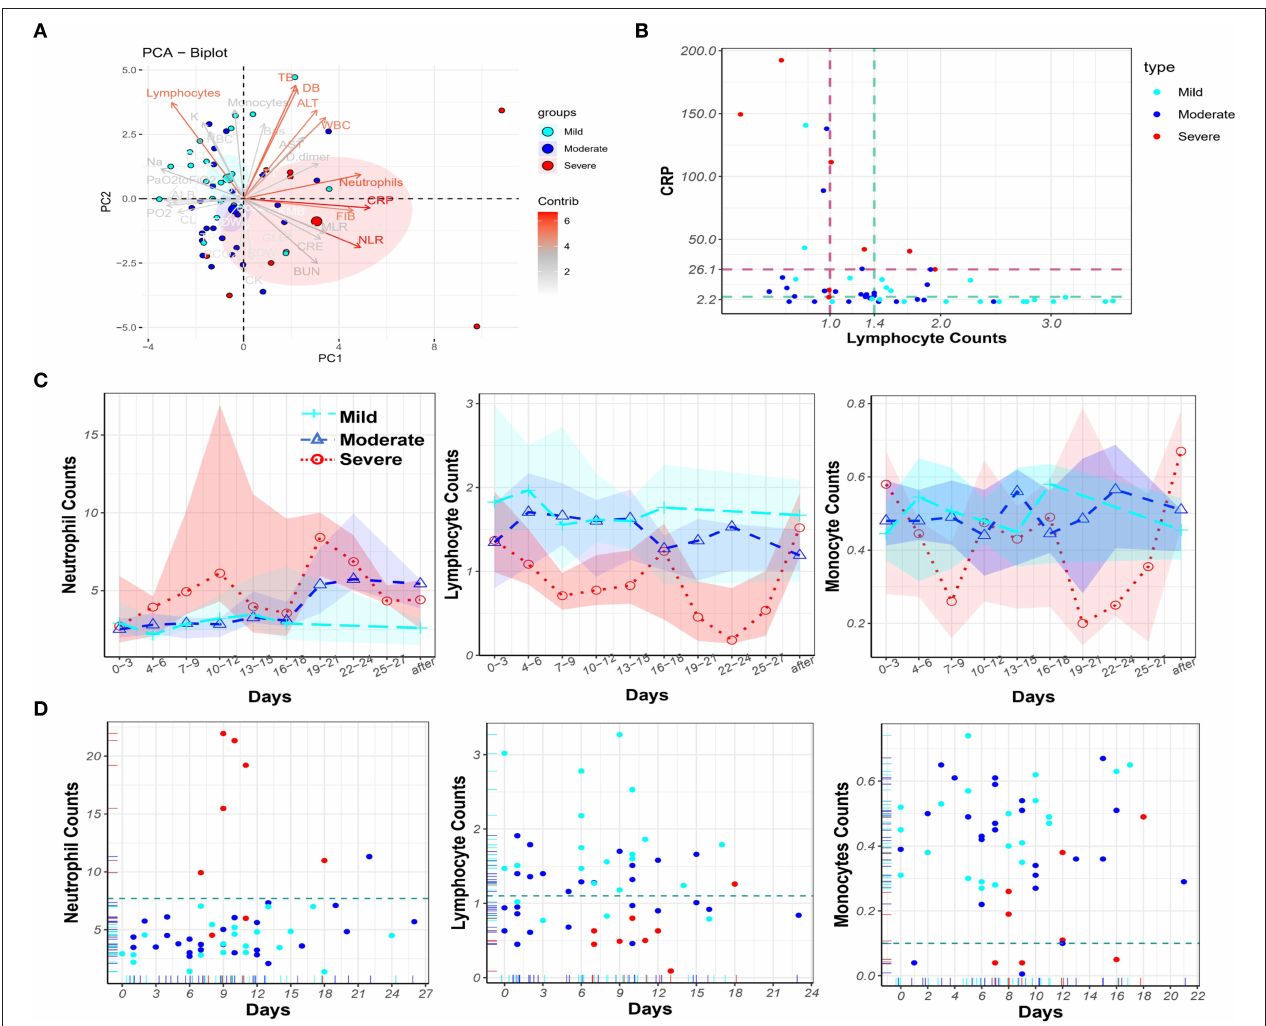
FIGURE 2 | Principal component analysis of laboratory parameters and dynamic monitoring of blood cells in the peripheral blood of COVID-19 patients. (A) Principal component analysis to identify variables for distinguishing the disease severity of COVID-19 patients. The nine variables that contributed mostly to distinguishing the disease severity were white blood cell counts (WBC), neutrophil counts, neutrophil-to-lymphocyte ratio (NLR), C-reactive protein (CRP), FIB, ALT, Total Bilirubin (TB), Direct Bilirubin (DB), and lymphocyte counts. (B) CRP levels and lymphocyte counts in 55 cases with the cut-off values CRP = 26.1 and lymphocyte = 1.0 for eight severe cases (brown) and the cut-off values CRP = 4.3 and lymphocyte = 1.4 for 22 mild cases (green). (C) The dynamic change of neutrophil, lymphocyte and monocyte counts over time in COVID-19 patients in mild (cyan), moderate (blue), and severe (red) groups, circled dots: mean value; colored background area: IQR (interval quartile range). The (D) Time points of maximum neutrophil, minimum lymphocyte, and minimum monocyte counts, and the corresponding counts in mild (cyan), moderate (blue), and severe (red) COVID-19 patients during